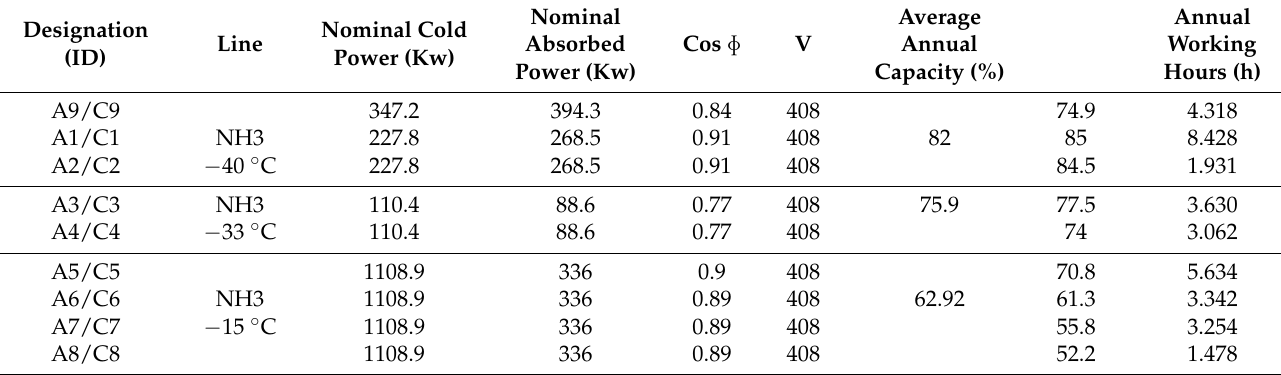
Figure 3. Sectorization of electricity consumption by main facilities. Table 1. Technical and operational characteristics of refrigeration